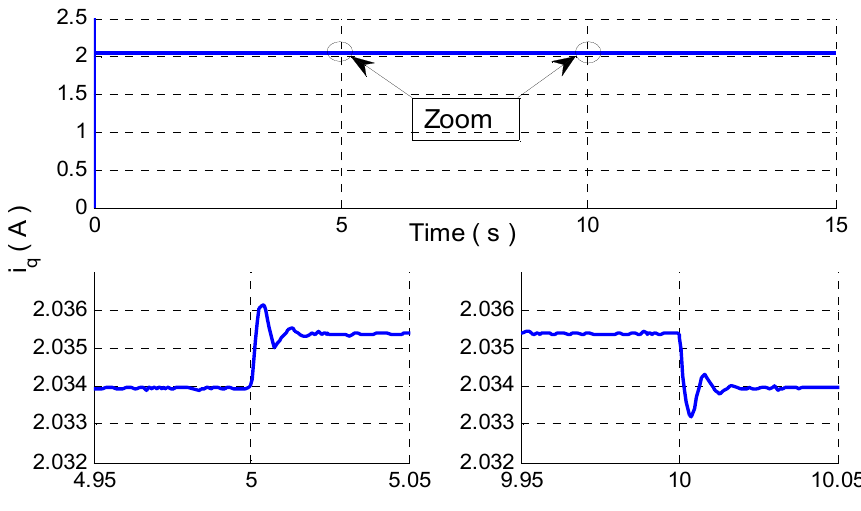
Figure 12. Load torque and electromagnetic torque with zoom. Figure 13 represents the variation in the quadratic current 𝑖 crease in the power drops of the SP ‐ PMSM.